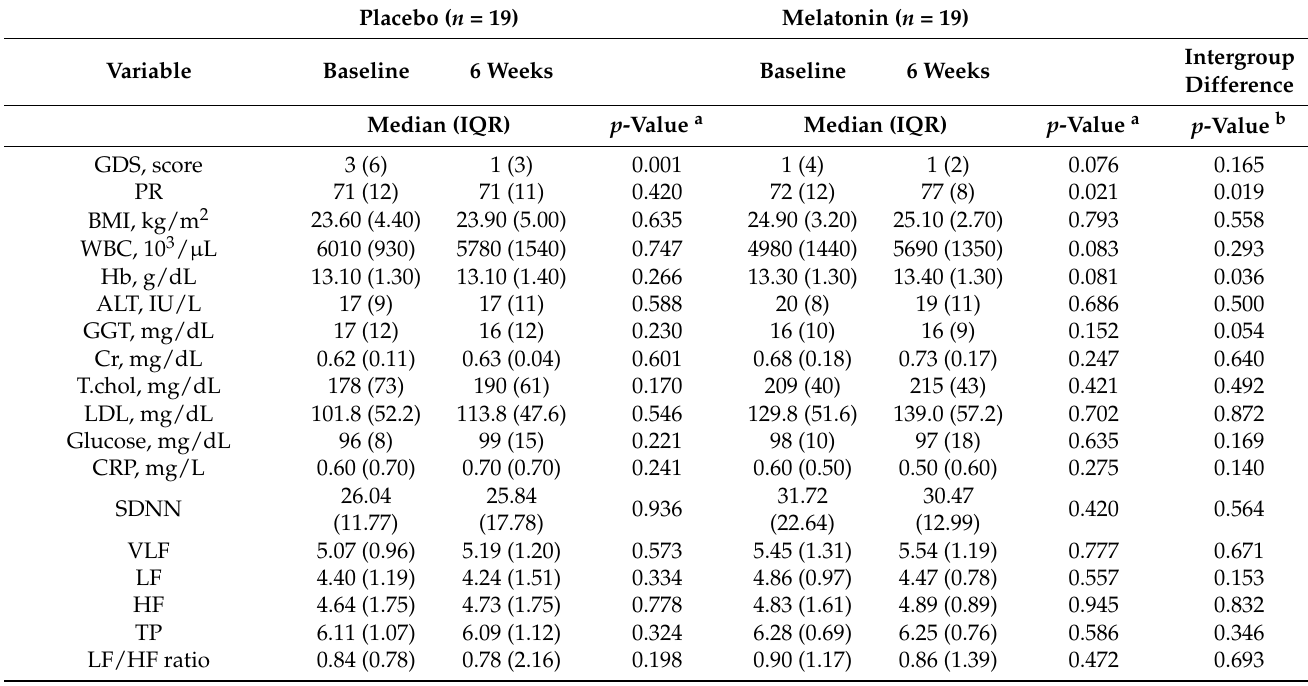
Table 3. Comparison of other metabolic